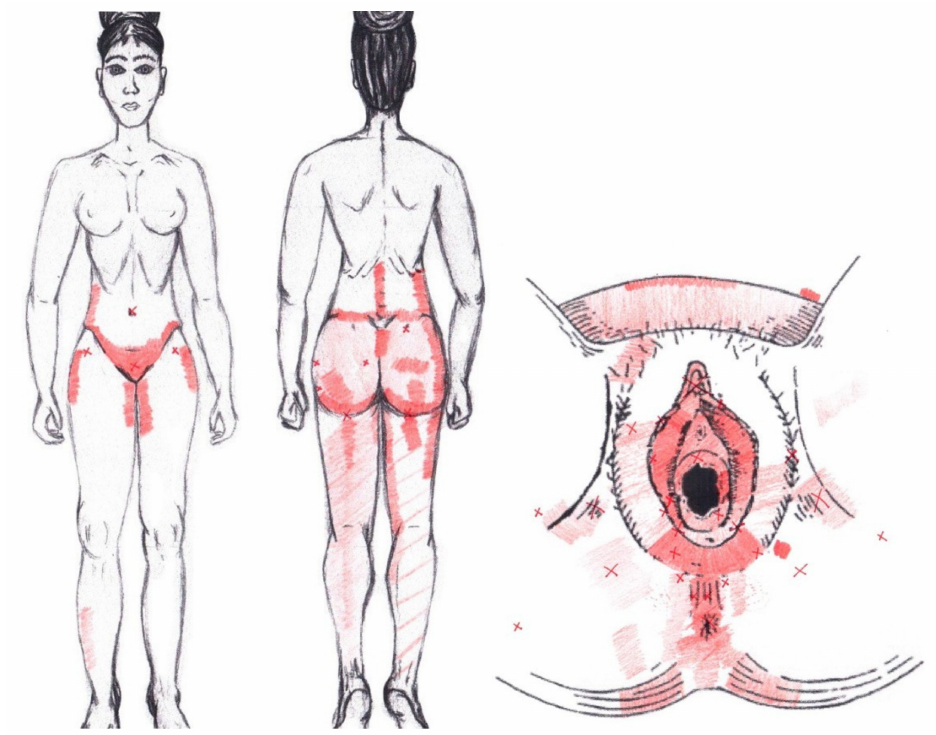
Figure 20. Graphical simulation of referred pain areas of the obturator internus muscle.